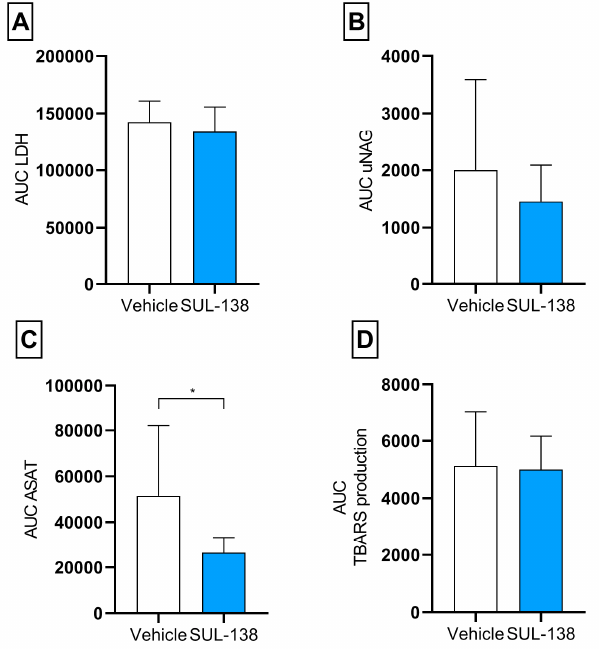
Figure 4. Kidney injury and oxidative stress markers released during 4 h normothermic machine perfusion. Porcine kidneys were tested for kidney function for 4 h with NMP after 24 h HMP with (SUL—138 • ) and without (Vehicle ⊗ ) SUL—138. ( A ) AUC for total LDH during NMP, ( B ) AUC for total uNAG between 120 and 240 min of NMP, ( C ) AUC for total ASAT during NMP, * p < 0.05 significant lower ASAT in SUL—138 group, ( D ) AUC for total TBARS levels during NMP. NMP, normothermic machine perfusion; AUC, area under the curve; HMP, hypothermic machine perfusion; LDH, lactate dehydrogenase; uNAG, urinary N—acetyl—beta—D—glucosaminidase; TBARS, thiobarbituric acid-reactive substances. The data are shown as mean ± SD.